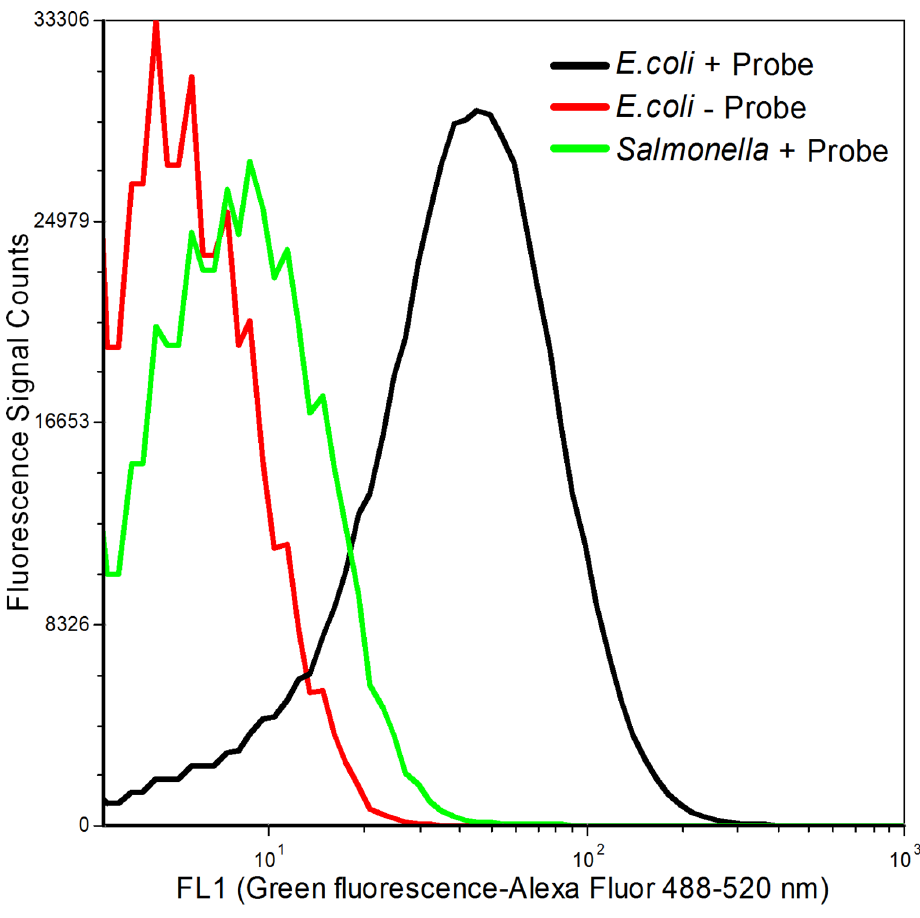
Fig 1. Fluorescence histogram of microorganisms hybridized with probe. Black line: E . coli O157 labeled with ES445-Alex probe; Red line: E . coli O157 with no probe; Green line: Salmonella enterica serovar choleraesuis (ATCC 10708) labeled with ES445-Alex